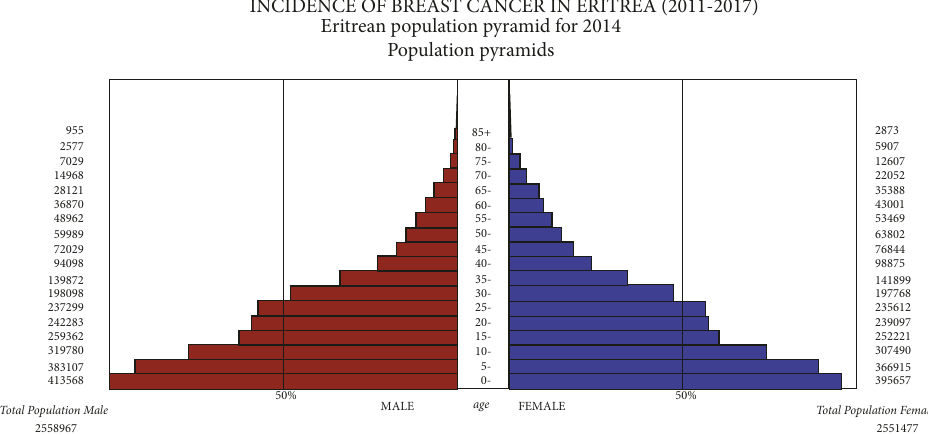
Figure 1: Eritrean population pyramid net 2014 (age-sex